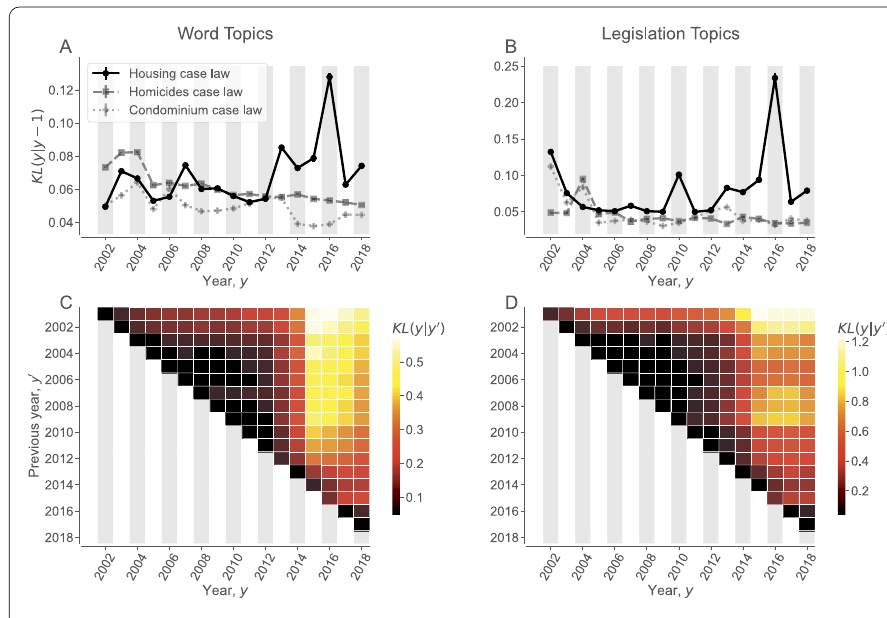
Figure 4 Kullback-Leibler (KL) divergence to measure surprise in the time evolution of topics. We use the KL divergence to measure the change in the topic distribution on year y with respect to the distribution on: ( A-B ) the year before; ( C-D ) a specific year y (cid:3) in the past (for the housing corpus only). Although the